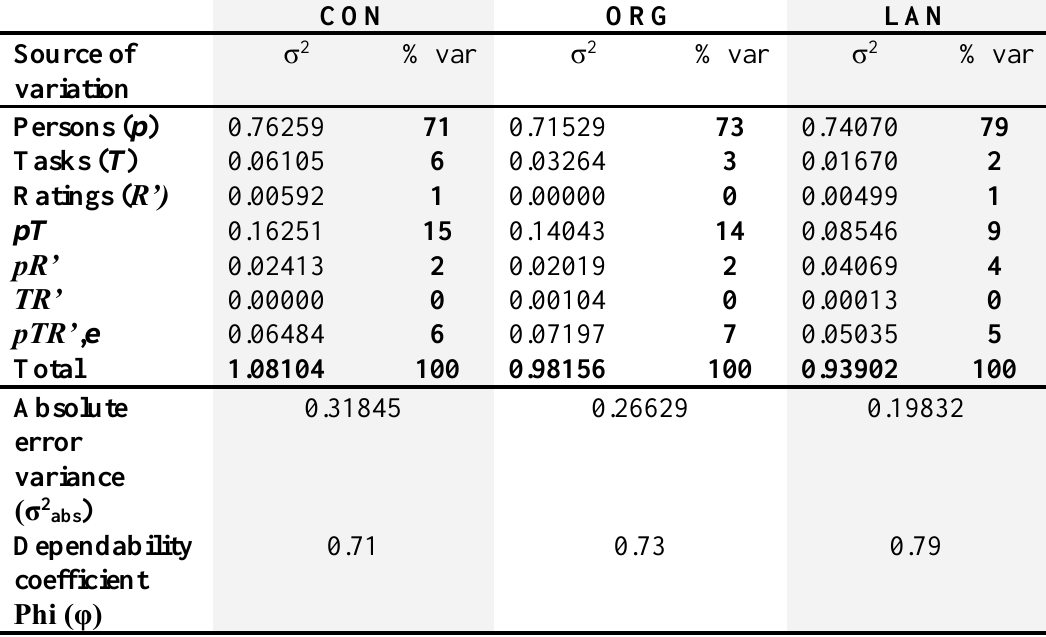
D-study Variance Components, Error, and Phi by Scale (2 tasks, 2